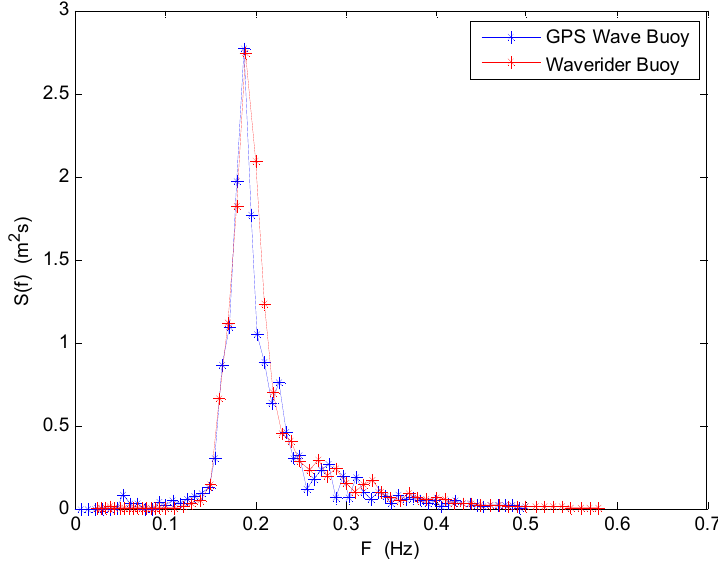
Figure 10. Comparison of wave frequency spectrum between the SBF7-1A GPS wave buoy and the DWR-MKIII Waverider buoy after correction at 03:00 (UTC) on 2 July 2013.